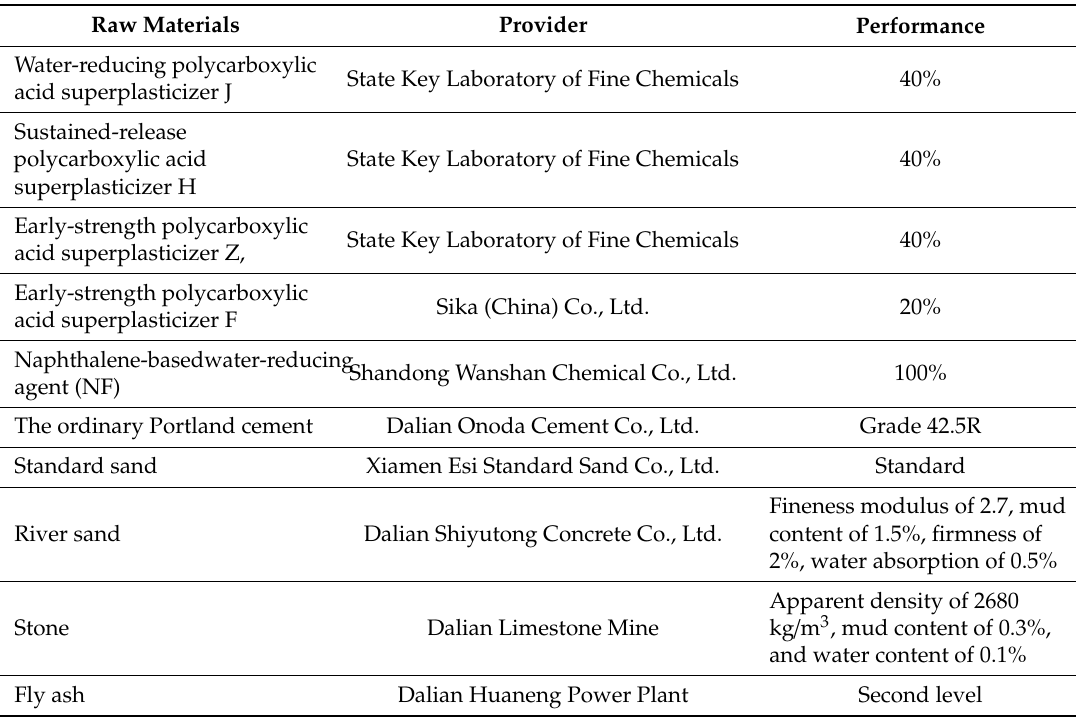
Table 1. List of raw